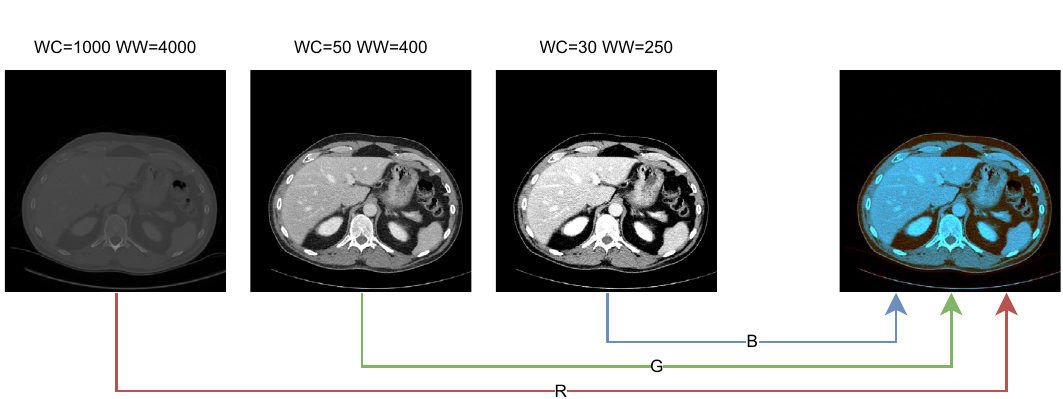
Figure 2. Visualization of the network inputs with multiple hounsfield windows applied. WC = Window Center, WW = Window Width. From left to right: all Hounsfield Units within 12-bit scanner data, abdominal soft tissue window, liver tissue window, and the composite RGB